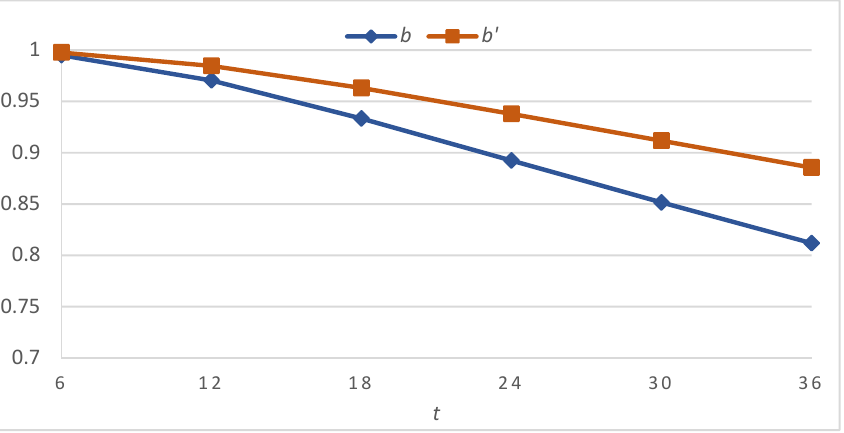
Figure 3. Bitcoin dependability before and after application of the DDAA under sets b and b ′ .